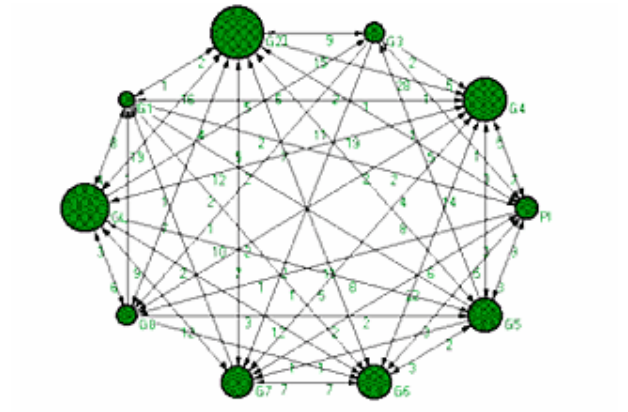
Figure 20. Directed network of hubs in the green group